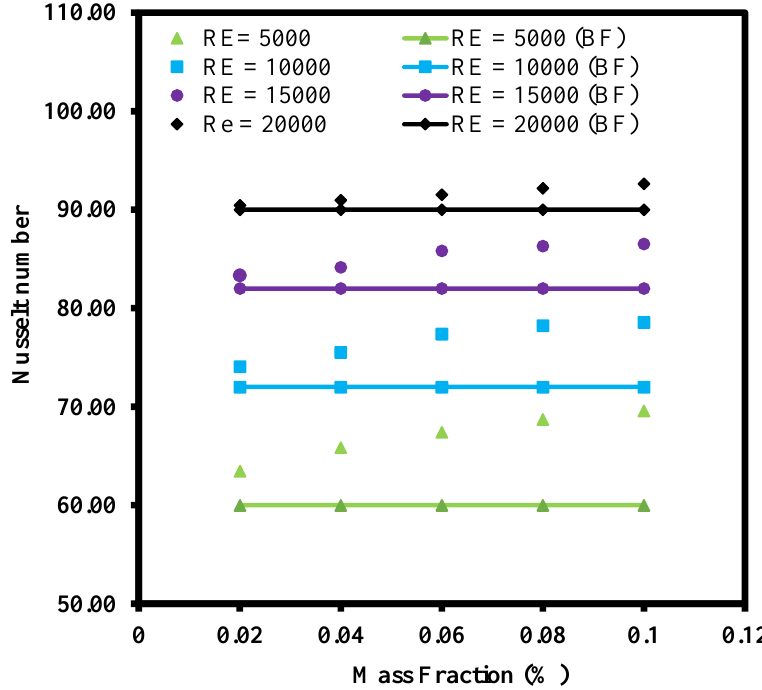
Figure 15. Thermographer images of ( a ) SIJ and ( b ) CIJ on heated plate.